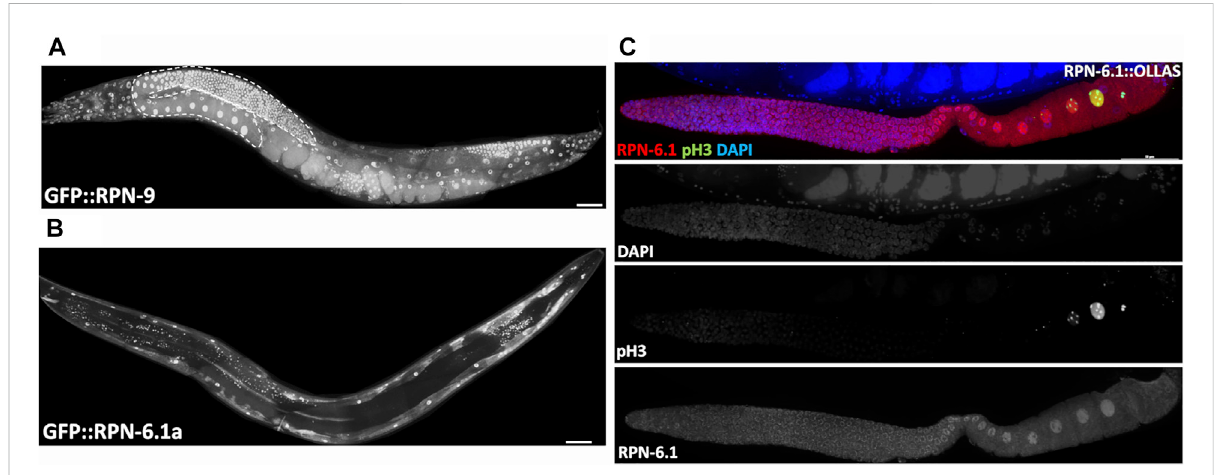
FIGURE 7 ThetwoRPN-6.1isoformsexhibitdifferentspatial localization.LiveimagingofhermaphroditesexpressingendogenouslyGFP-tagged (A) RPN- 9 and (B) RPN-6. Strains are WDC5 rpn-9[ana5 (gfp::rpn-9)] and WDC3 rpn-6.1a [ana3(gfp::rpn-6.1a)] . (C) Immuno fl uorescence image of rpn-6.1 [ana12(rpn-6.1::ollas)] strain dissected gonad co-stained with anti-OLLAS (red), anti-pH3 (green, condensed chromatin) and DAPI for DNA (blue). Anti-pH3 was used solely to con fi rm presence of maturing oocytes. Bright nuclear and relatively dim cytoplasmic RPN-6.1b expression shown throughout germ line. Scale bar, 50 µm.